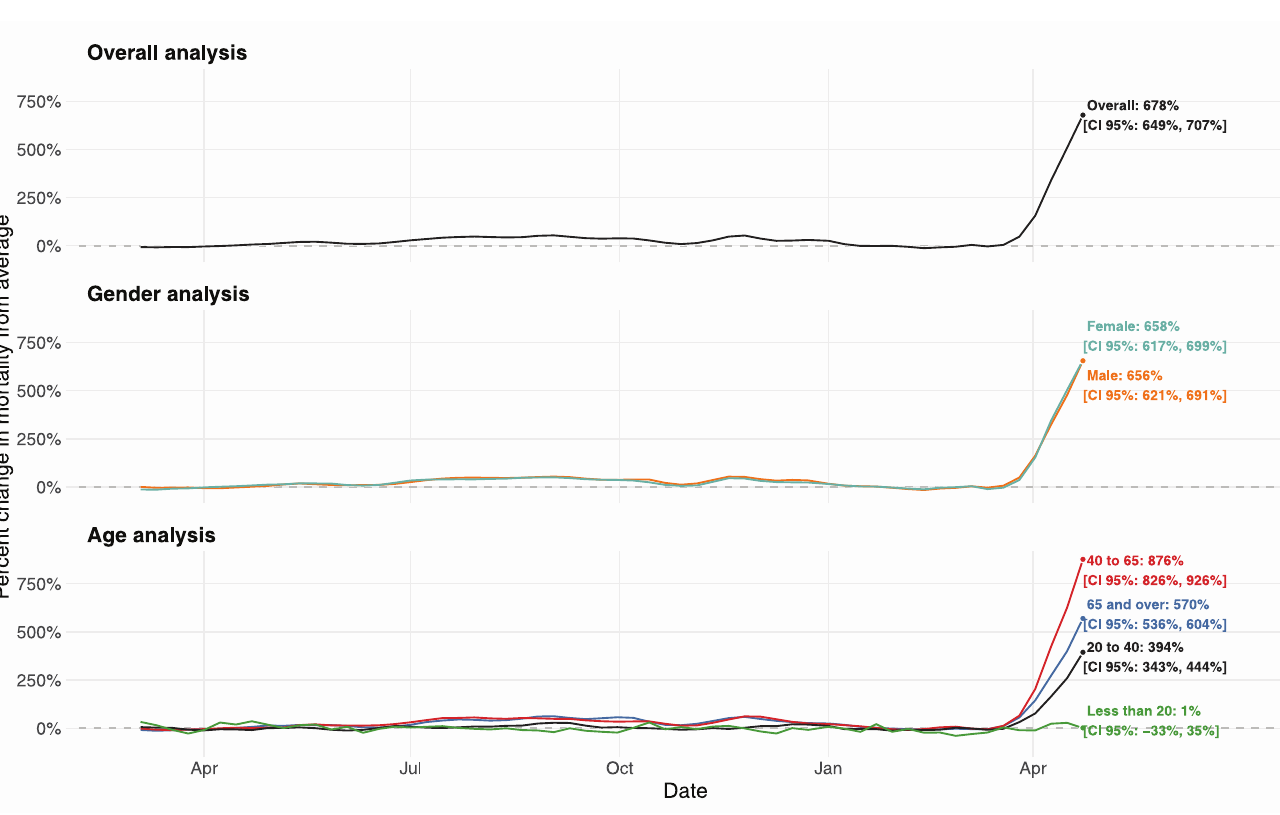
Fig 2. Estimated percent change in mortality from average in Gujarat, India, from March 2020 to April 2021. The solid-curves represent percent changes from average mortality for each group. 95% confidence intervals were omitted for better readability. The point estimate and corresponding 95% confidence intervals for April 16, 2021, the week of peak excess mortality, are displayed in text on the right and highlighted with a data point.